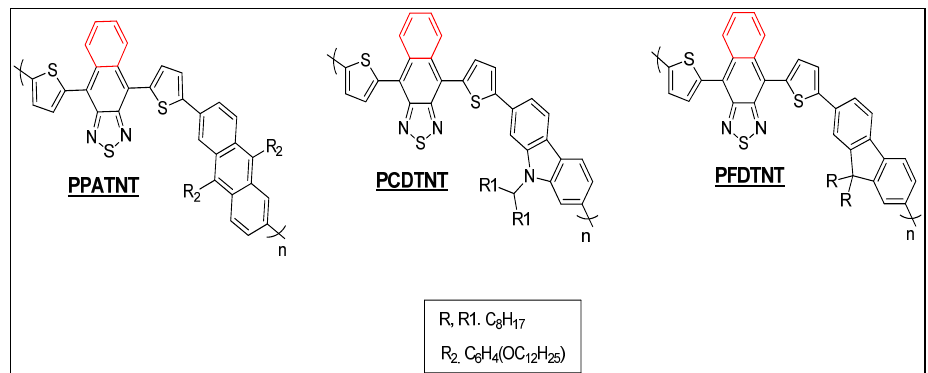
Figure 29. Molecular structure of NT-based polymers.